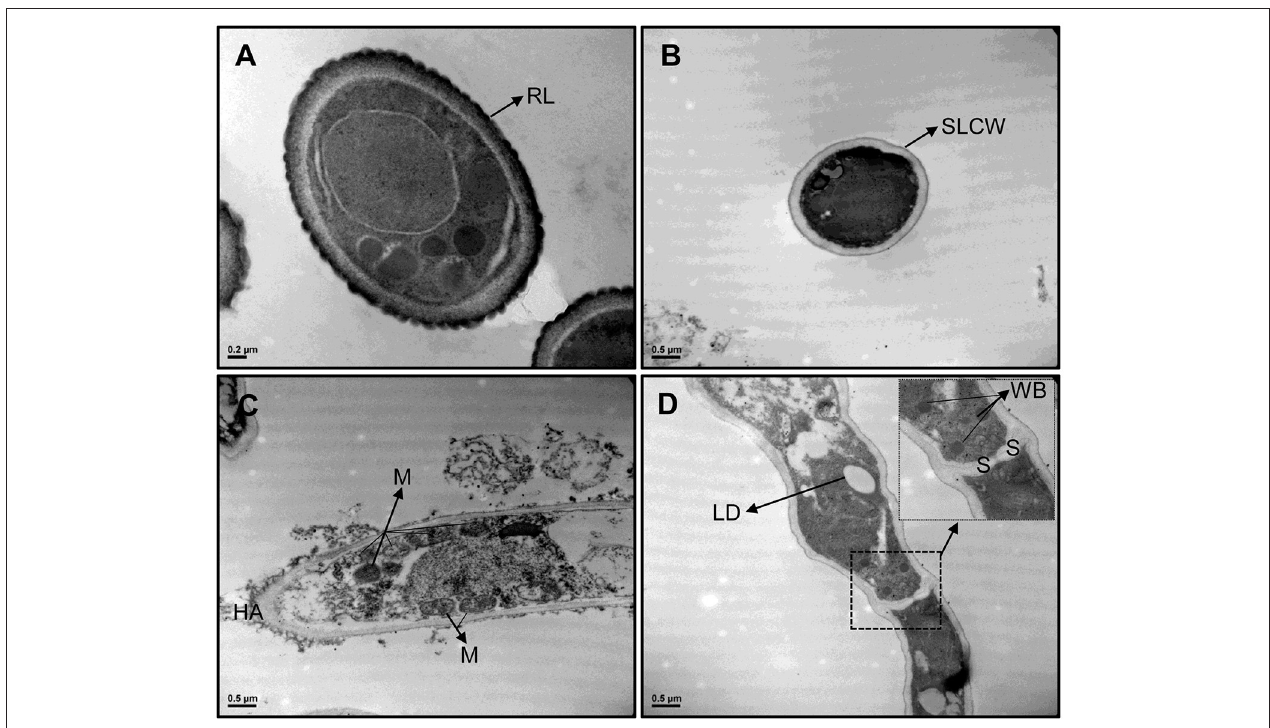
FIGURE 4 | TEM images from Metarhizium robertsii ARSEF 2575 conidia (A) and microsclerotial propagules (B–D) at 30,000 × magnification stained with DAB. Cross section of both propagules showed differences in cell wall and ultrastructure morphology. Because of DAB reaction, microsclerotia exhibited black dots and black areas inside the cells, in hyphal apex, and in cell interconnections. Several mitochondria, peroxisomes, and Woronin bodies are visible and strongly stained in microsclerotia, but not in conidia. RL, rodlet layer; SLCW, single layered cell wall; HA, hyphal apex; M, mitochondrium; LD, lipid droplet; WB, Woronin body; S,